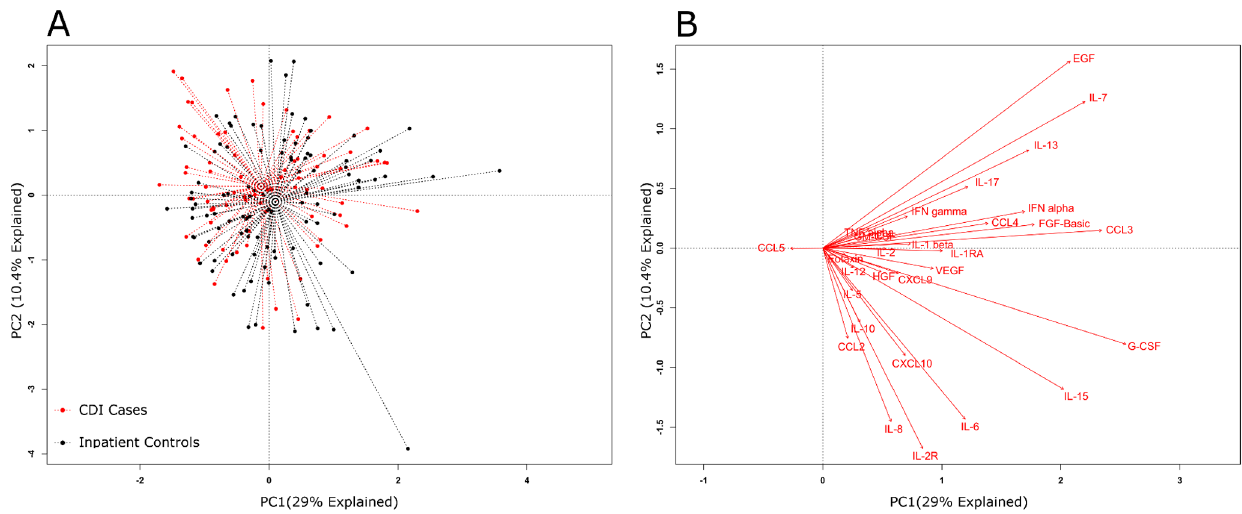
Figure 3. Global systemic inflammatory responses in C.difficile infection (CDI) cases and inpatient controls. Principal component analysis (PCA) (panel A) results are shown for CDI cases and inpatient controls. The individual inflammatory mediators’ effects on the PCA were plotted as biplots (panel B). In biplots the arrows indicate the direction of maximum change while the length of arrows represents the magnitude of the change. The PCA centroids were not significantly different by permutational MANOVA testing ( P =.051).